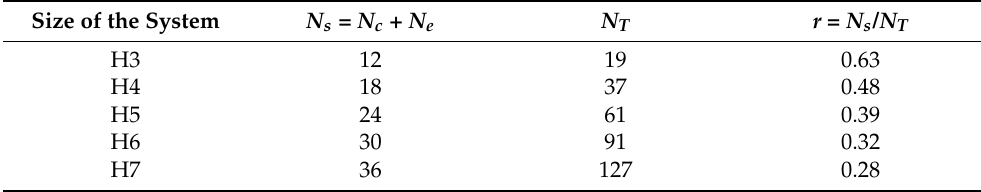
Table 2. Values of the ratio parameter r for different sizes of hexagonal-shaped systems. Size of the